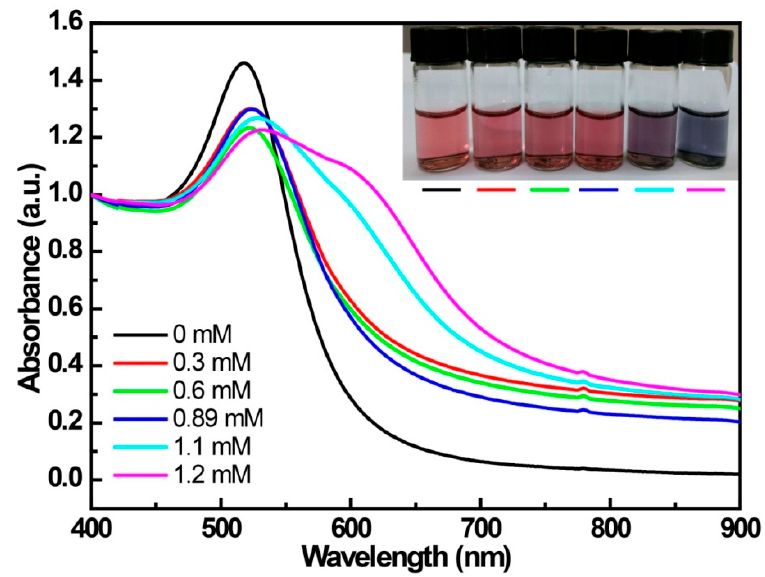
Figure 1. The change in the UV ‐ Vis spectrum of citrate ‐ capped gold nanoparticles (AuNPs) with the addition of different amounts of 4 ‐ mercaptophenylboronic acid (4 ‐ MPBA).